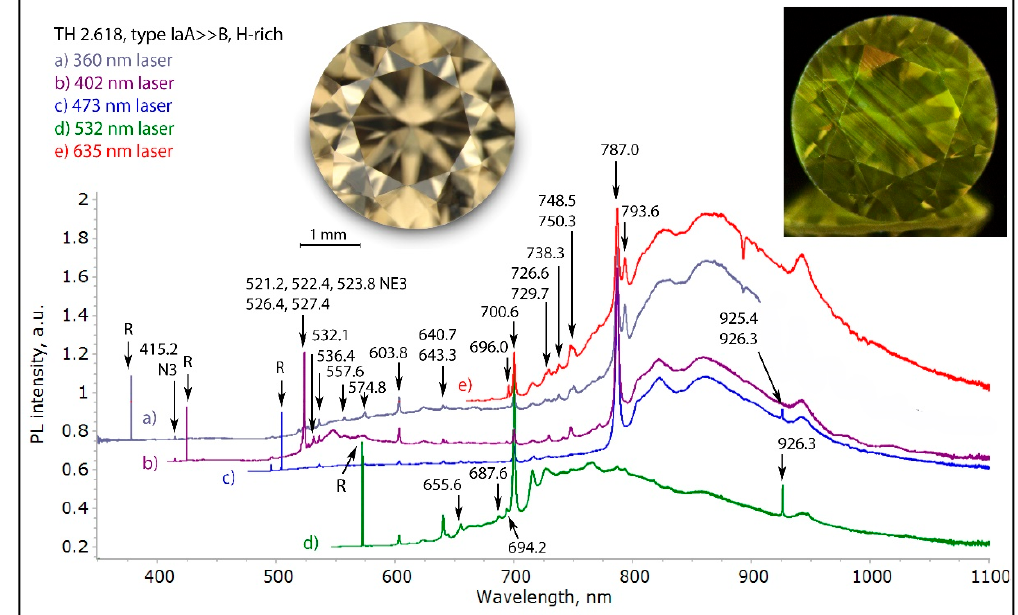
Figure 24. The photoluminescence spectra of a NDR hydrogen-rich yellow brown type IaA >> B diamond (TH 2.618) recorded with five different lasers. The 521.2 to 527.4 nm features, the 700.6, the 787.0 and the 793.6 nm centers are characteristic for such diamonds; at least the 700.6 and 793.6 nm centers are linked to nickel-related defects. The spectra have been shifted vertically for clarity. Photos: Gianna Pamies and Dr. Thomas Hainschwang.